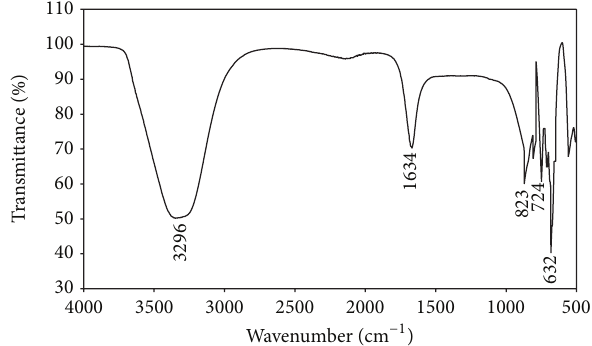
Figure 6: FTIR spectrum of aqueous leaf extract of M. tinctoria